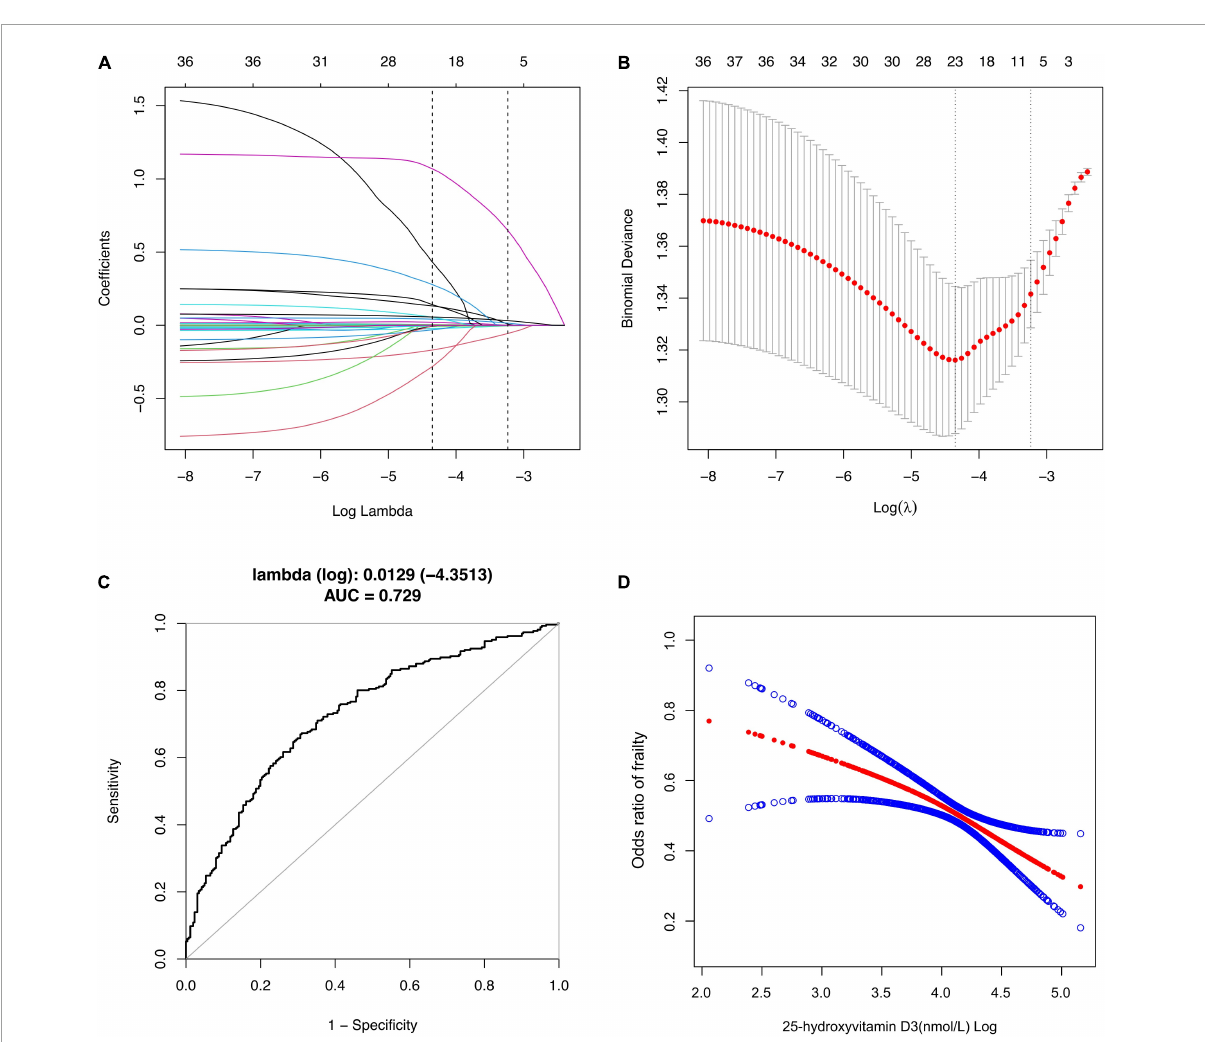
FIGURE2 Selection of Variables using LASSO regression. (A) Lasso coefficient of 31 variables in model 1; (B) the optimal penalty coefficient [Lambda (log) = 0.0129] in the Lasso regression was identified with the minimum criterion; (C) Receiver operating characteristic (ROC) curves according to LASSO Regression; (D) The relationship between Vitamin D3 and Frailty. Solid rad line represents the smooth curve fit between variables according to GAM. Blue bands represent the 95% of confidence interval from the